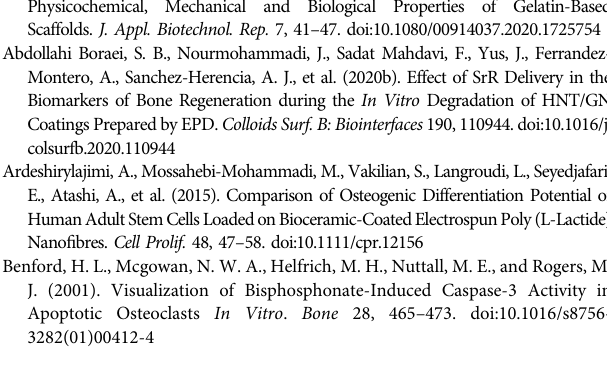
Frontiers in Bioengineering and Biotechnology |